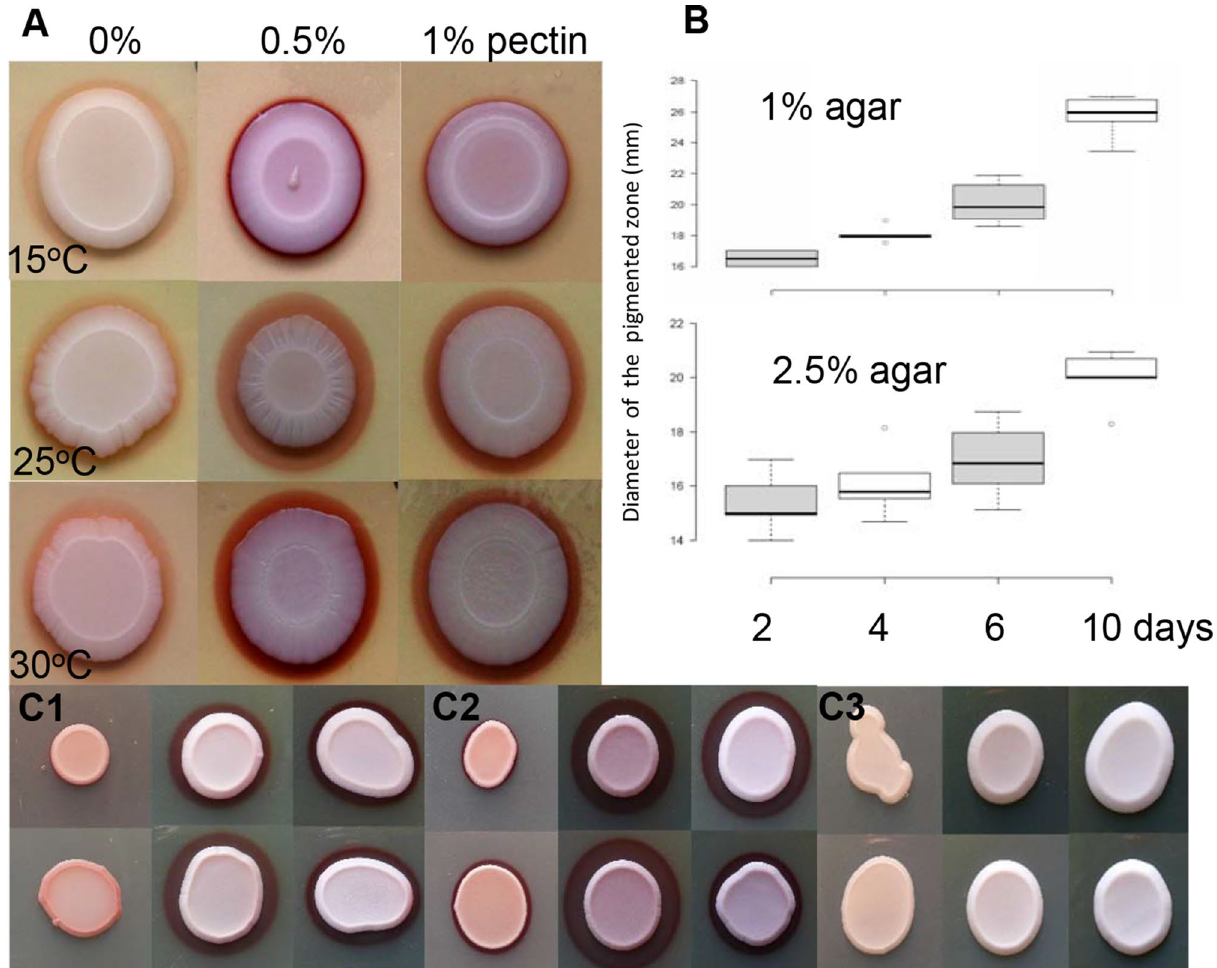
Figure 3. Effect of polysaccharides on pigment production. The presence of the pectin favoured production of a dark red pigmented zone ( A ), while agar influenced rather localisation of the pigment ( B ) and not the pigment intensity ( C ). Size of the pigmented zones on YPA containing 1 and 2.5% agar (6-6 Petri dishes were measured after 2, 4, 6, 10 days. Statistical analysis was created by BoxPlotR program ( B ). SMA, YEA YPA media (from right to left) were incubated at 25 °C and photographed after 5 days ( C1,2,3 ). Upper line contained 1.5% agar, bottom line contained 2.5% agar. ( C1 ) M. andauensis (11–1120), ( C2 ) M. pulcherrima (11–578), ( M. pulcherrima (11–11) gave similar results), ( C3 ) M. crysoperlae (11–1158)